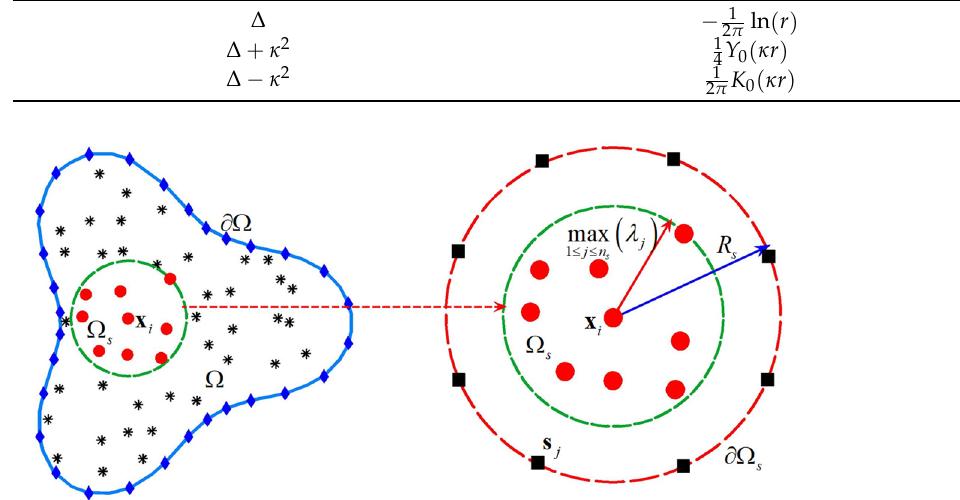
Table 1. Fundamental solutions of different differential operators in two-dimensional cases [31]. (cid:60) or L m G ∆